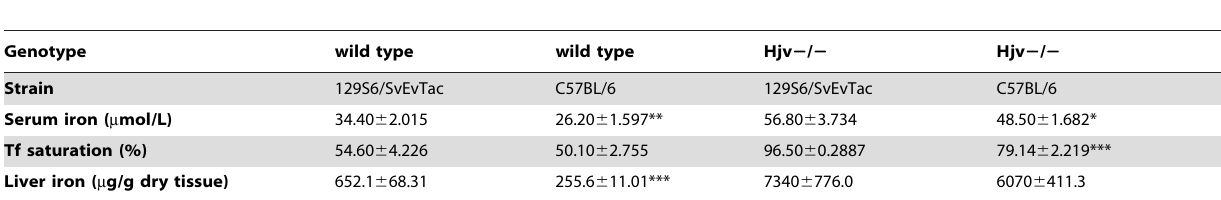
Table 2. Serum and liver iron indices in wild type and Hjv 2 / 2 mice of 129S6/SvEvTac or C57BL/6 genetic background (n= 10 male